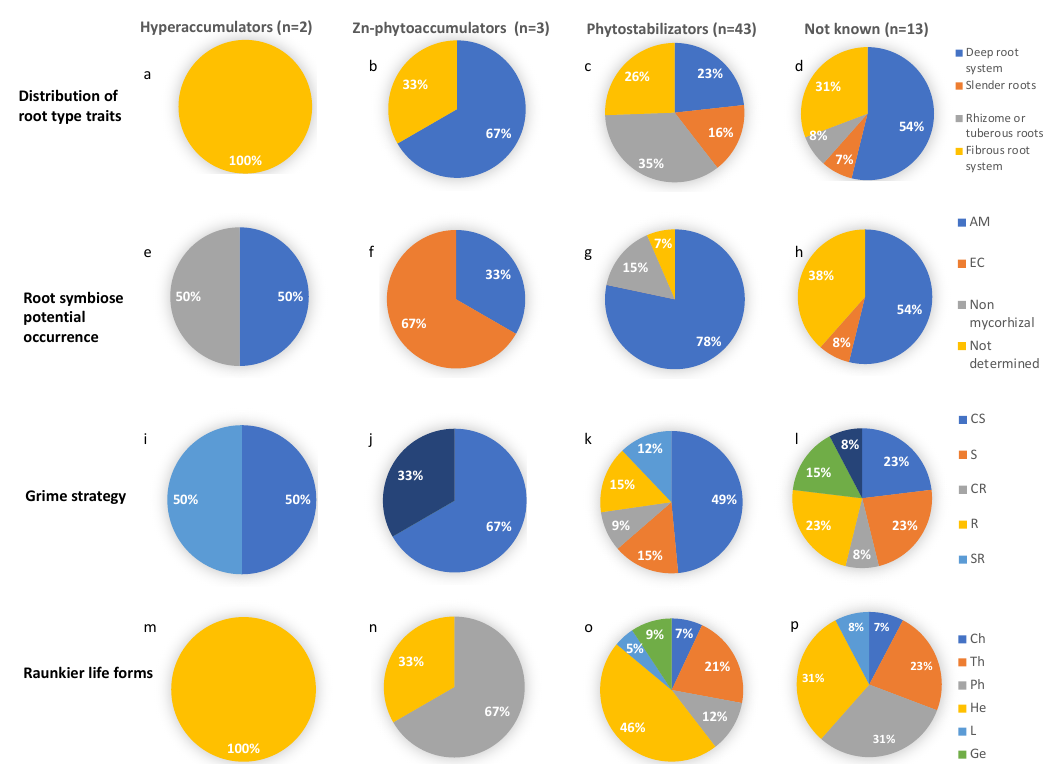
Figure 6. Distribution pattern of root type traits ( a – d ), root symbiosis potential occurrence ( e – h ), Grime strategy ( i – l ) and Raunkiær life forms ( m – p ) by TMM tolerance strategy, i.e., hyperaccumulators ( N. caerulescens (Zn / Cd / Pb- hyperaccumulator) and B. leavigata (Tl / Pb / Cd- hyperaccumulator)), Zn-phytoaccumulators ( Plantago lanceolata , Quercus ilex and, Pinus sylvestris ), phytostabilizators or not known in the literature (see Table A1).